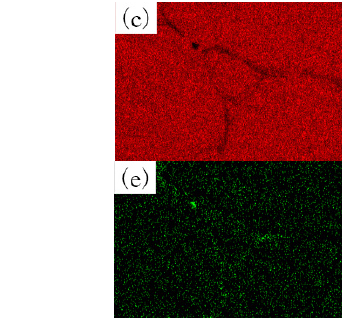
Figure 11. SEM/EDS images for OABs of aluminum wires with a 160 A overcurrent: ( a ) SEM image; ( b ) total element mapping; ( c ) Al mapping; ( d ) O mapping; ( e ) Cl mapping. 4. Conclusions This paper analyzes the effects of current on the microscopic characteristics of alumi- num alloy wire OABs and clarifies the difference between OABs in aluminum alloy and aluminum wires. The conclusions are as follows: (1) Under the rated current of aluminum alloy wires and aluminum wires, there are no obvious grain boundaries or grain characteristics in the metallographic structure of the wires. Furthermore, large amounts of Al-Si and Al-Fe binary phases are distributed in the α -Al matrix. (2) After an overcurrent occurs in the wires, the metallographic structure of the alu- minum alloy wire OABs consists of cellular dendrites, and the second phase disappears. As the current increases, the grain size gradually decreases.